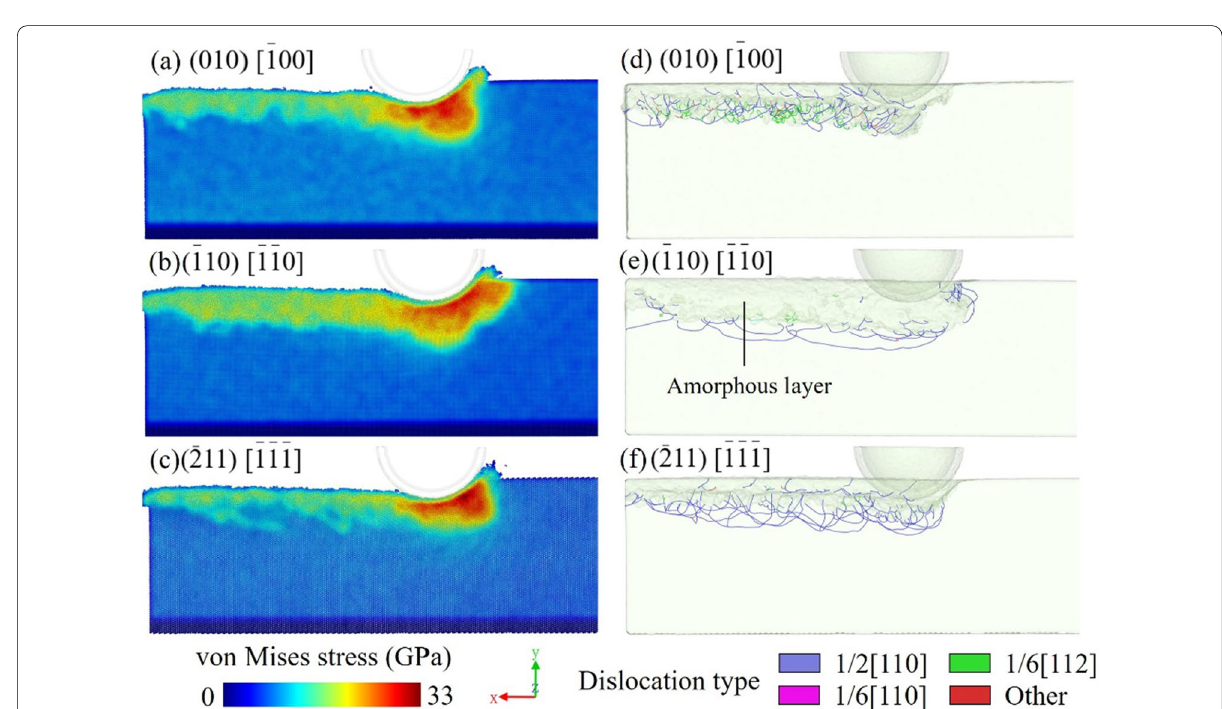
Fig. 13 Von Mises stress distribution and dislocation distribution in the models with cutting orientations along a , d ( 010 ) [ 100 ] , b , e ( 110 ) [ 110 ] , and c , f ( 211 ) [ 111